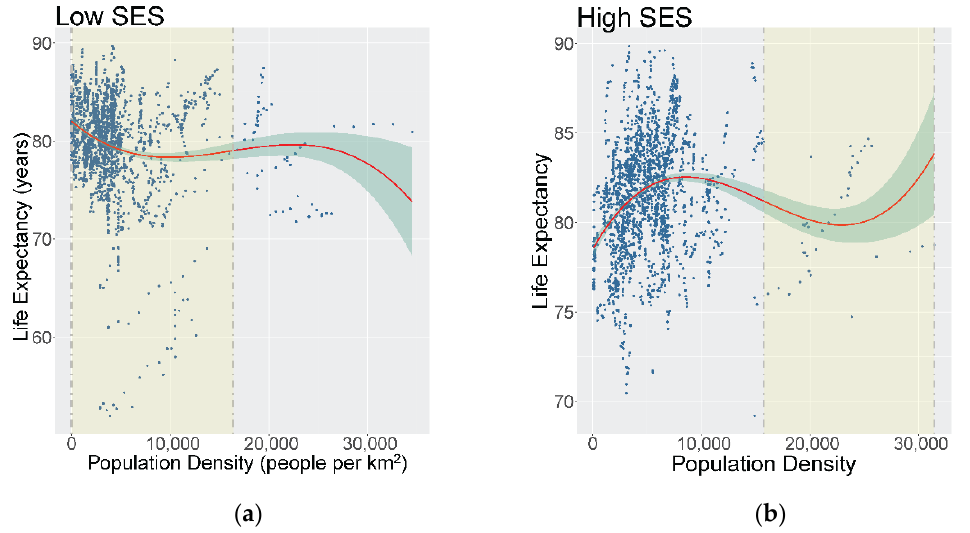
Figure 4. ( a ) Smoothed cubic spline population density (people per km 2 ) and life expectancy at birth for low SES CTs with the shaded areas representing the ‘optimal ranges’ identified, Metro Vancouver, 1990–2016; ( b ) Smoothed cubic spline population density (people per km 2 ) and life expectancy at birth for high SES CTs with the shaded areas representing the ‘optimal ranges’ identified, Metro Vancouver, 1990–2016.